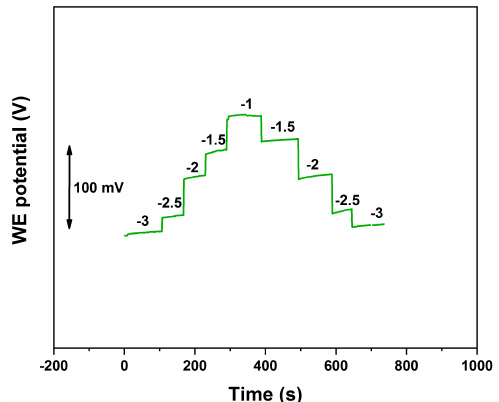
Figure 6. Reversed calibration between 10 − 3 and 10 − 1 M of for a Li + SC-ISE on micro-electrodes. Platinum nanoflowers were deposited by LSV2.